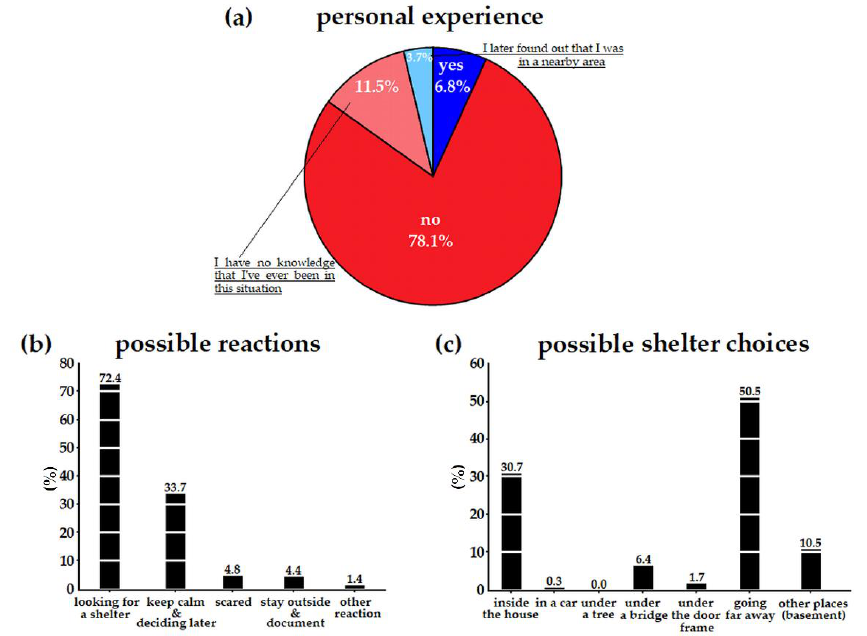
Figure A3 . The summary results of question Q10 to Q12 regarding: the respondents’ personal experience with tornadoes ( a ), their possible reactions ( b ) and their shelter choices in case of tornado experience ( c )